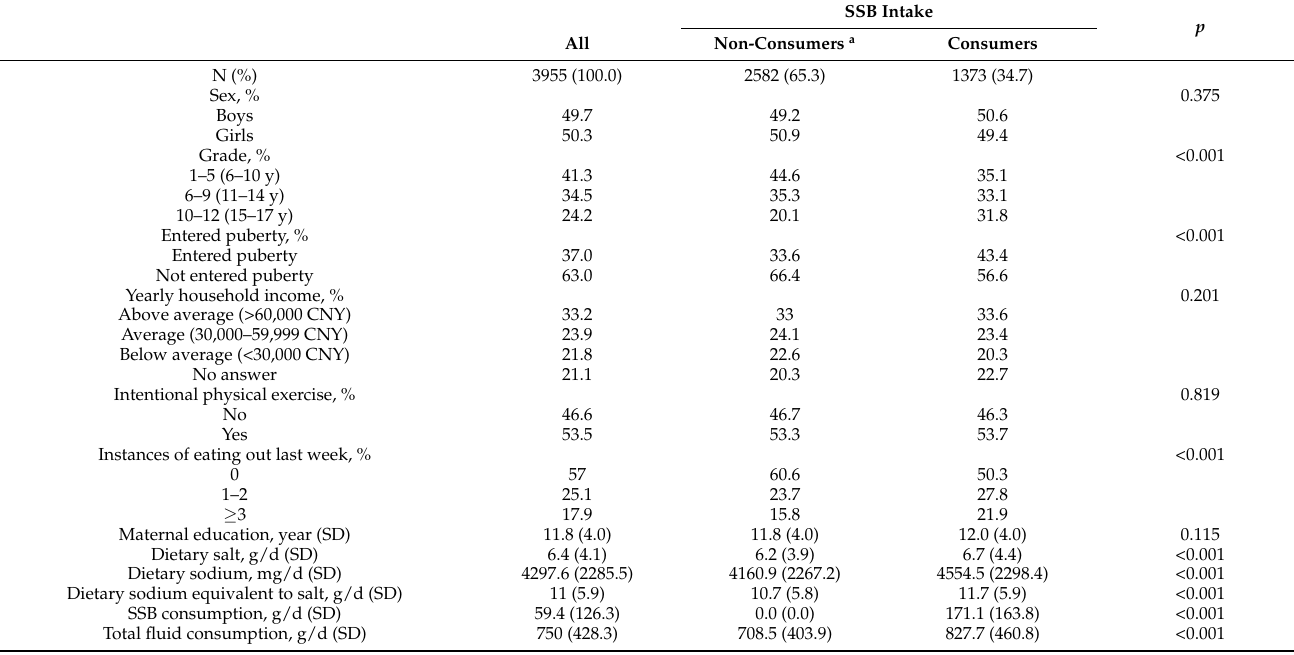
Table 1. Characteristics of the